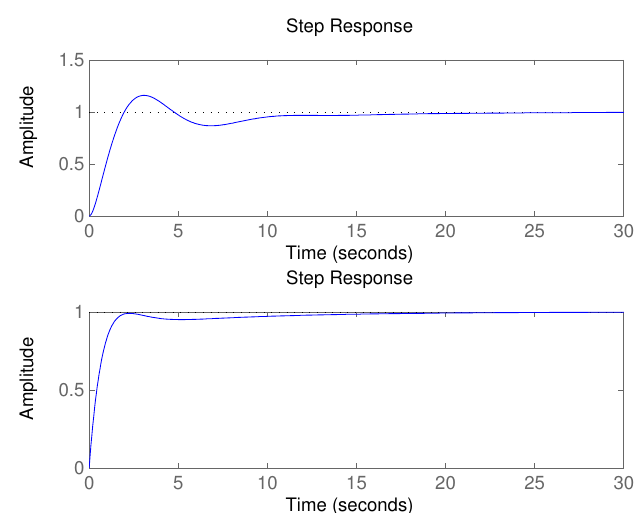
Figure 12. Step response of initial ( upper ) system and changed ( lower ) controlled system according to the simulation of monitoring system